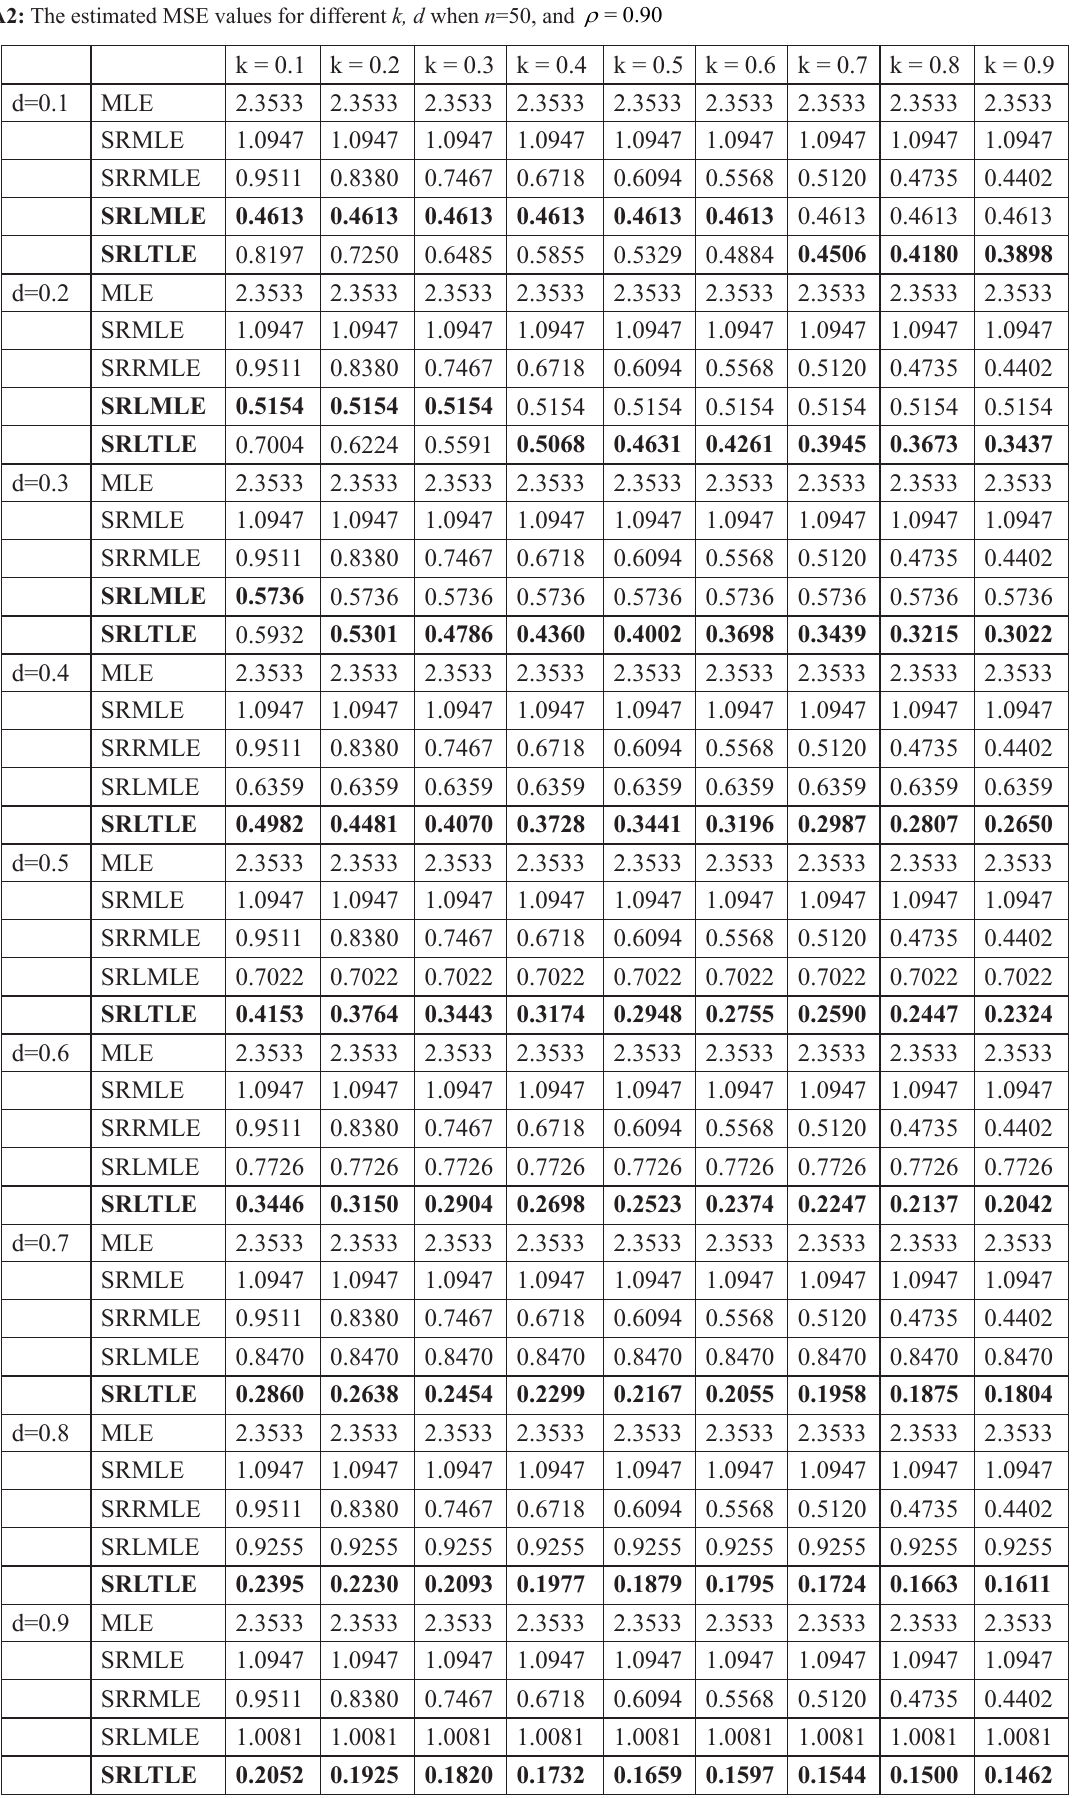
Table A2: The estimated MSE values for different k, d when n =50, and 0.90= ρ k = 0.1 k = 0.2 k = 0.3 k =